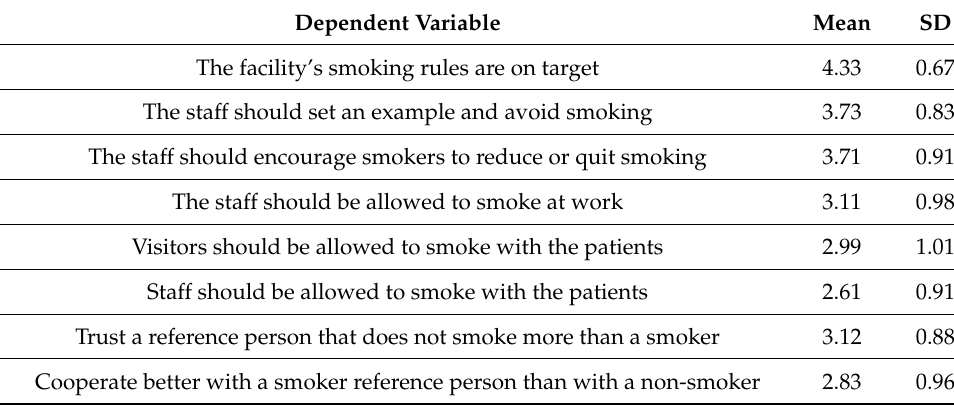
Table 4. Patients’ attitudes toward smoking in the facility environment.